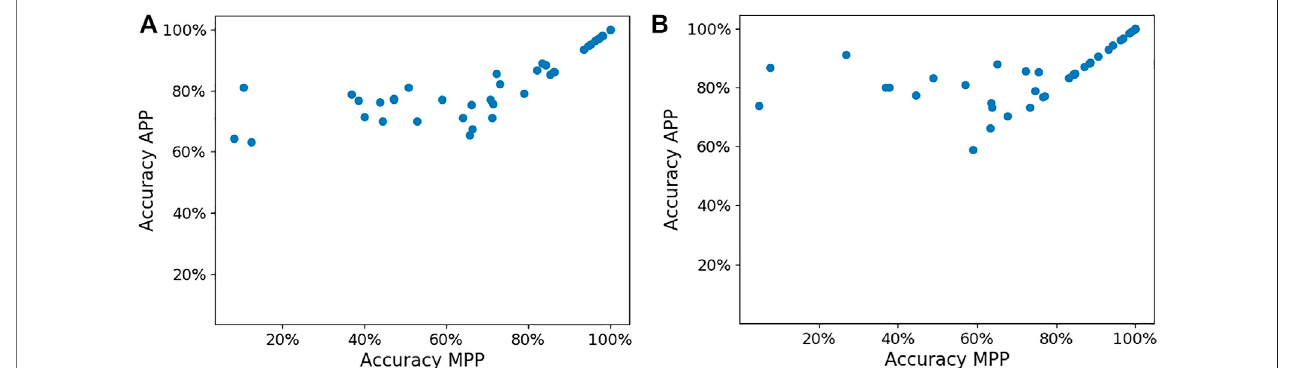
FIGURE 7 | Panels (A,B) show the femoral and tibial implant size in the MPP and APP, respectively, for each